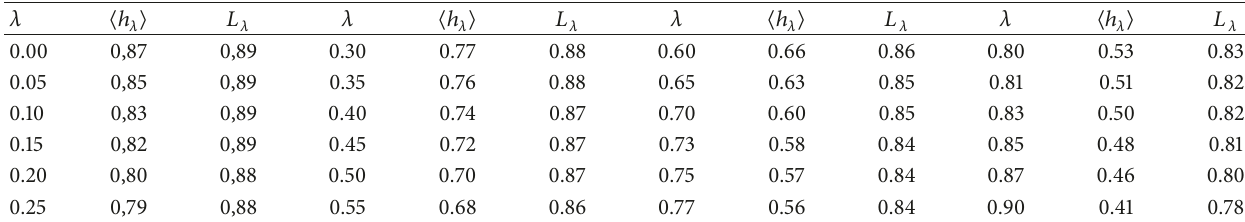
Table 3: The averages for ⟨ℎ 𝜆 ⟩ and 𝐿 𝜆 for each 𝜆 obtained with the data generated for Case I. 𝜆 ⟨ℎ 𝜆